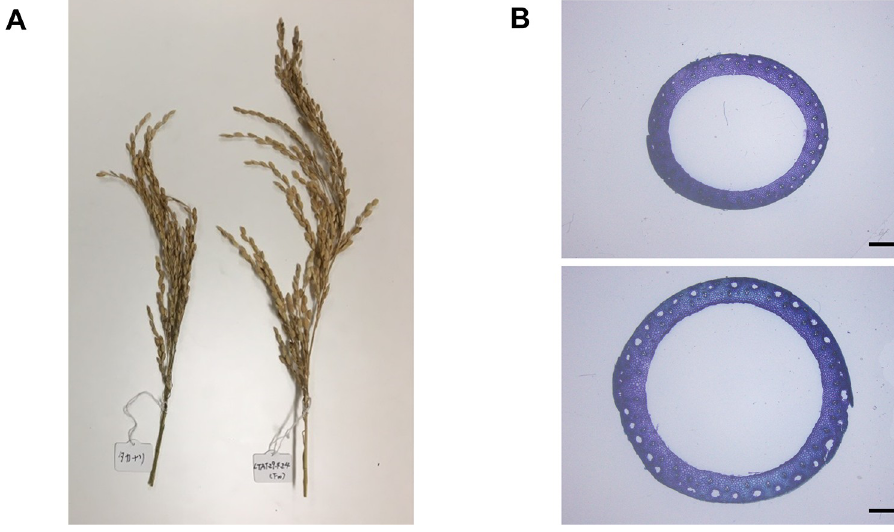
Fig 3. Panicle appearance and cross sections of basal elongated internodes. (A) Left and right panicles indicate Takanari and Monster Rice 1, respectively. (B) Upper and lower figures indicate cross sections of Takanari and Monster Rice 1, respectively. Black bar indicates 1